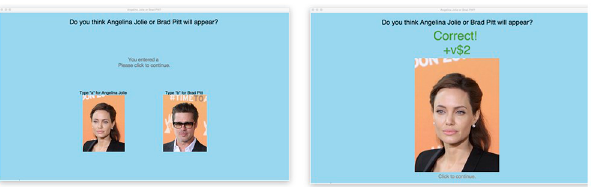
Fig 2. Screenshots of the experimental program. The left image shows the screen before the user submits her guess, and the right image shows the screen displaying the result of a correct guess. The pictures of Angelina Jolie and Brad Pitt are republished from Foreign, Commonwealth & Development Office under a CC BY license, with permission through creativecommons.org, original copyright 2014. We use different images of Angelina Jolie and Brad Pitt in the study, and the screenshots here are therefore for illustrative purposes